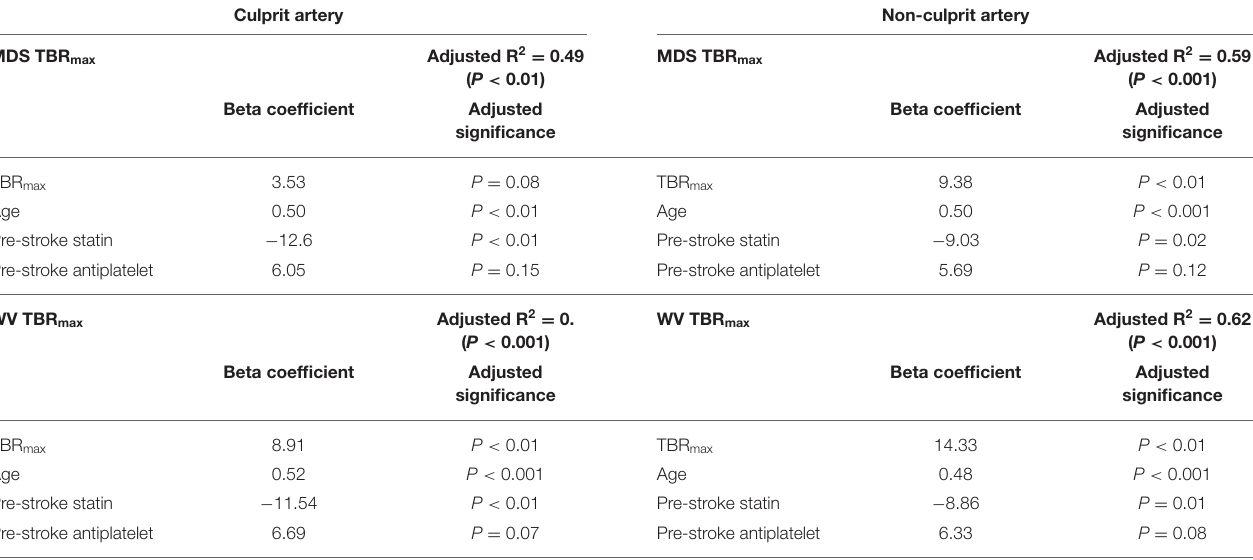
TABLE 4 | Linear regression for white matter hyperintensity volume (mL) for focal (MDS) and whole vessel (WV) FDG uptake in culprit and non-culprit carotid